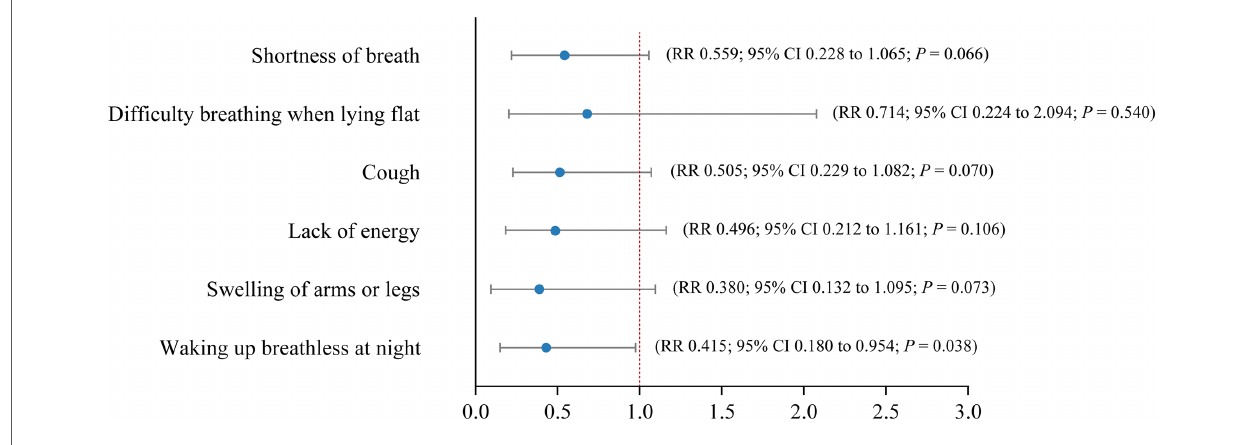
FIGURE 2 Forest plot showing estimates of RRs with 95% CIs of symptom prevalence between the TOLF-HF intervention and control groups after controlling for baseline prevalence values and the number of co-morbidities. RR, risk ratio; CI, con fi dence